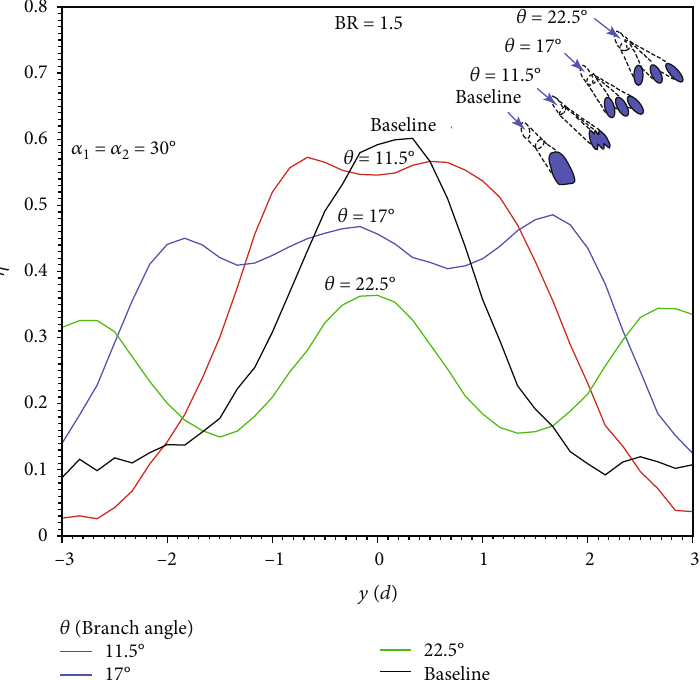
Figure 23: Spanwise (streamwise-averaged) fi lm e ff ectiveness variations at x / d = 5 for α ratio of BR = 1 : 5